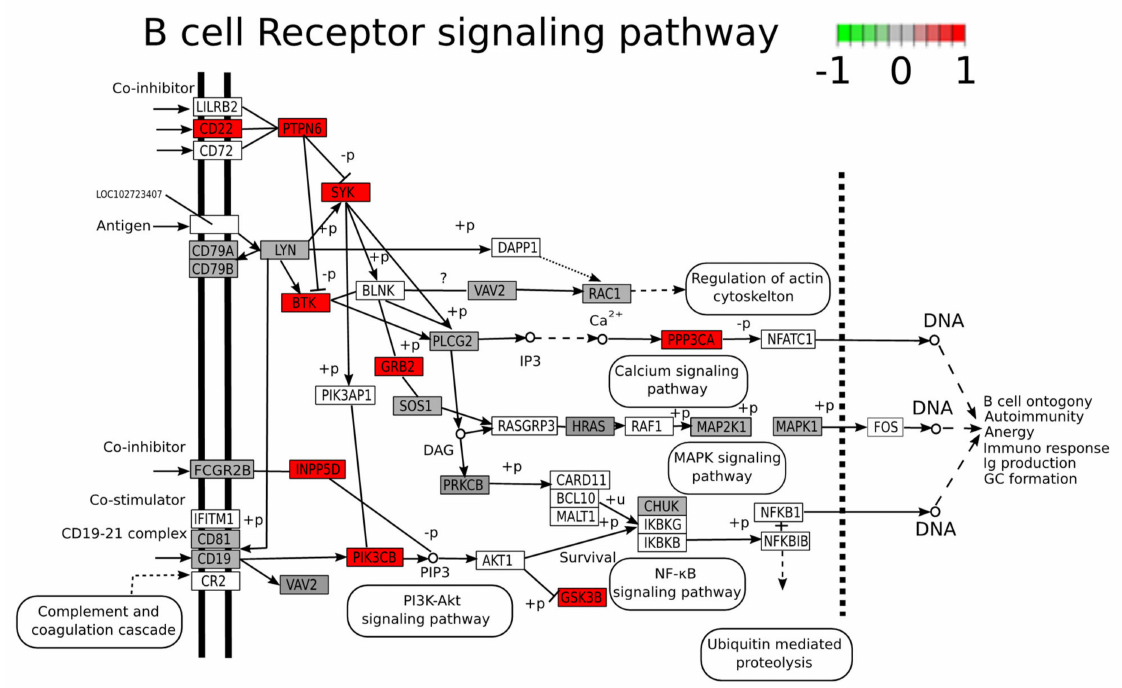
Figure A10. B-cell receptor signaling pathway with identified proteins from EVs color coded according to log 2 fold change. Log 2 fold change from nonsignificantly regulated proteins based on the adjusted p value were set to zero before plotting with the R package